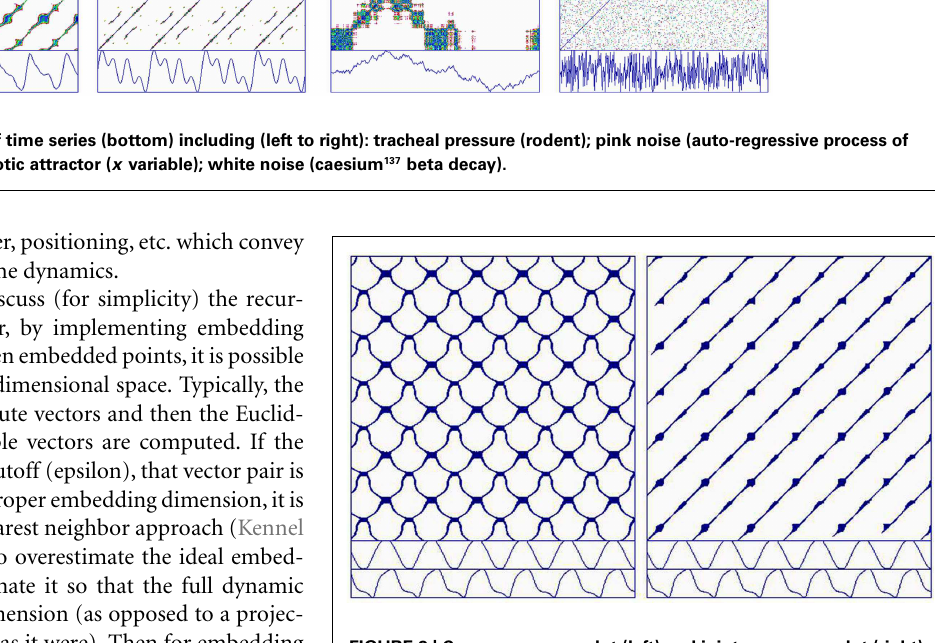
FIGURE 8 | Cross recurrence plot (left) and joint recurrence plot (right) of a fluid-coupled system consisting of an independent sinusoidal driver (upper trace) and dependent coupled rotor (lower